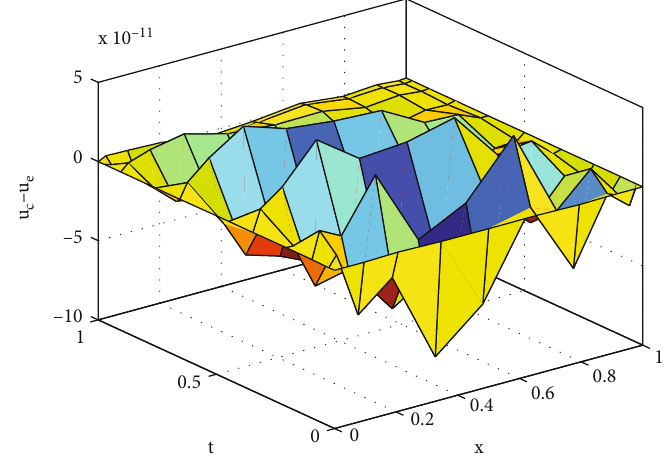
Figure 3: Errors of Chebyshev nodes for LBRCM with m = n = 10, d